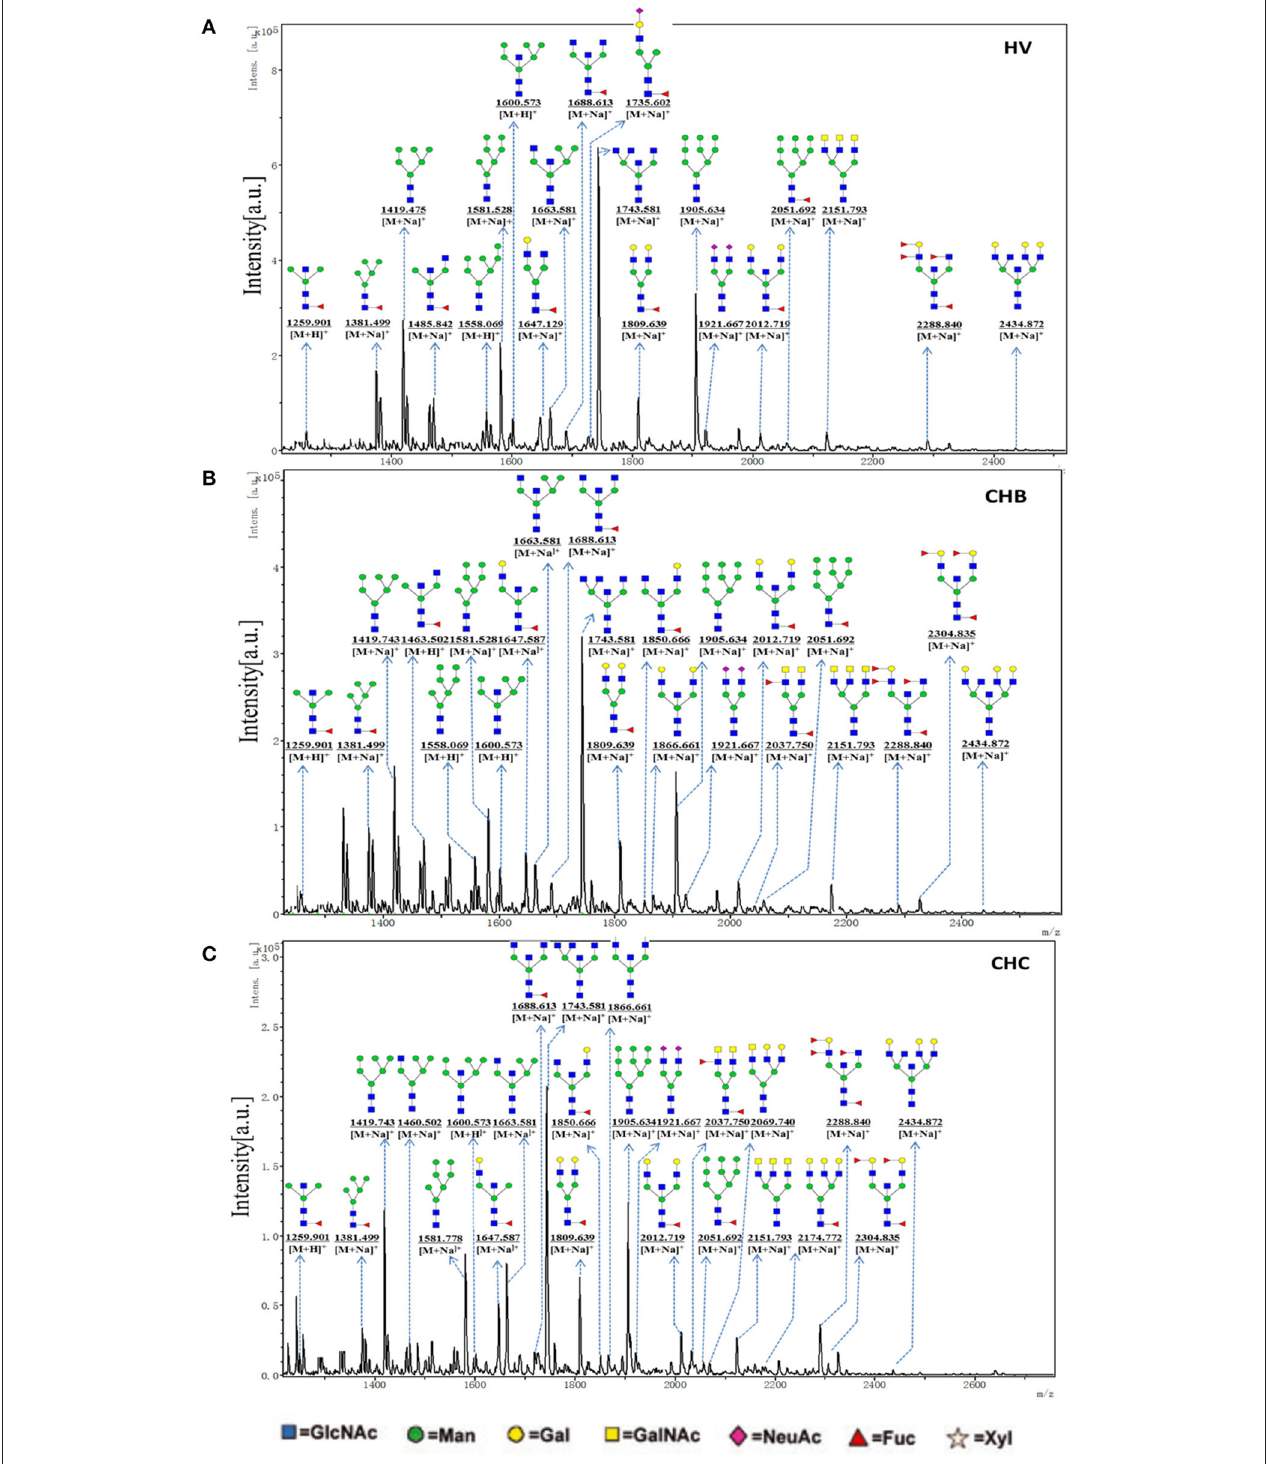
FIGURE 4 | One MALDI-TOF-MS spectra of the PNGase F released N -linked glycan from the PHA-E + L affinity glycoproteins of the serum from HVs, CHB, and CHC patients. (A) Glycan spectra of HVs; (B) Glycan spectra of CHB patients; (C) Glycan spectra of CHC patients. Proposed structures and their m/z values are shown for each